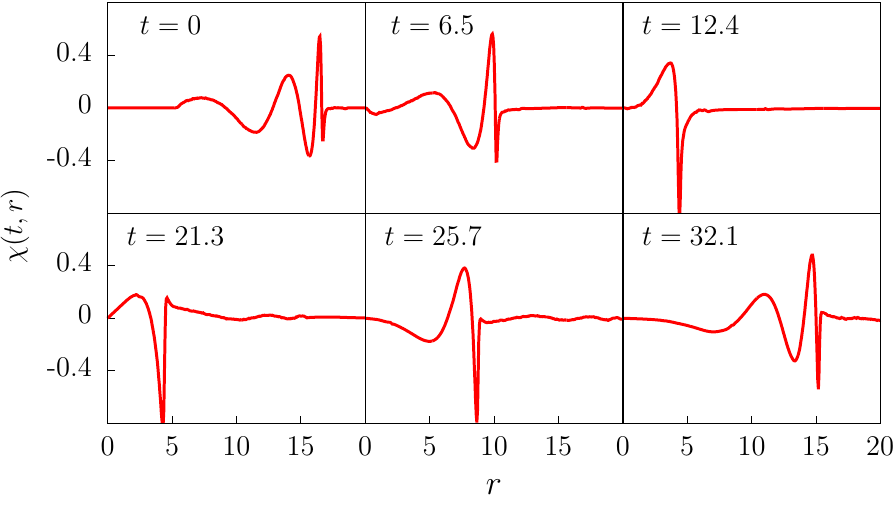
Figure 3 . Time evolution of the (cid:12)eld (cid:31) ( t; r ) = (cid:30) ( t;r ) N r = 400 ; R =